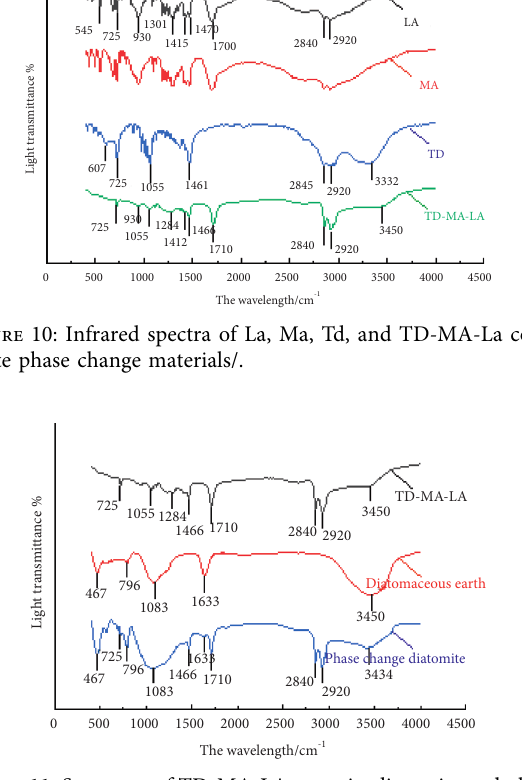
Figure 11: Spectrum of TD-MA-LA eutectic, diatomite and phase change